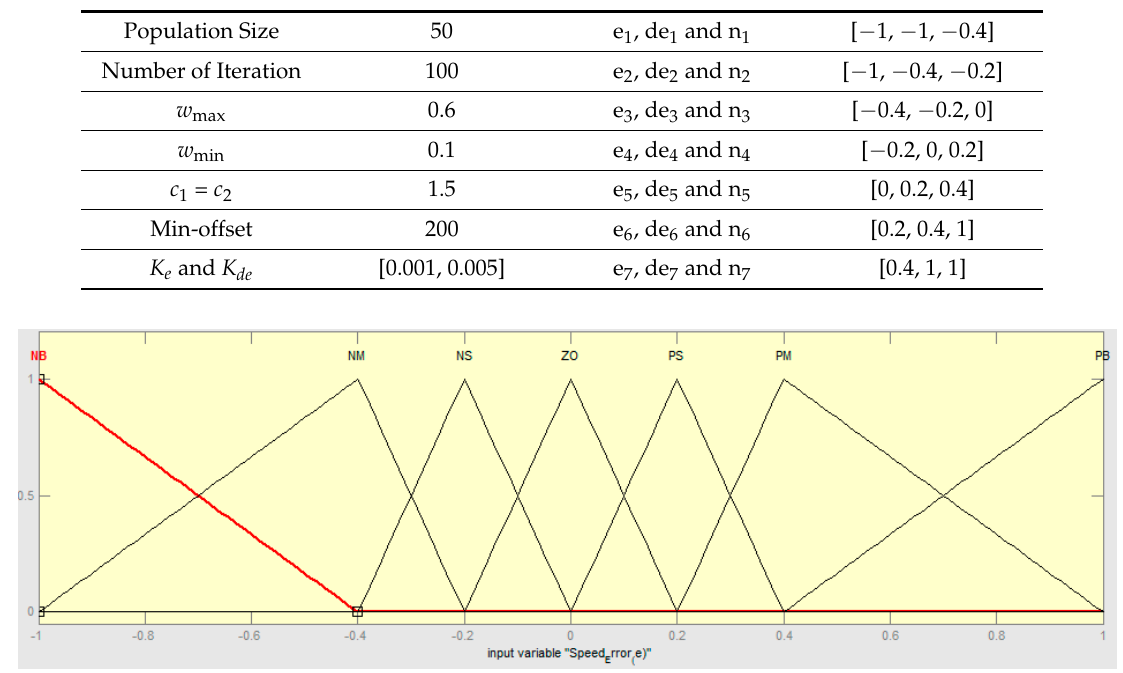
Figure 13. Membership function of speed error (e) optimized by PSO.